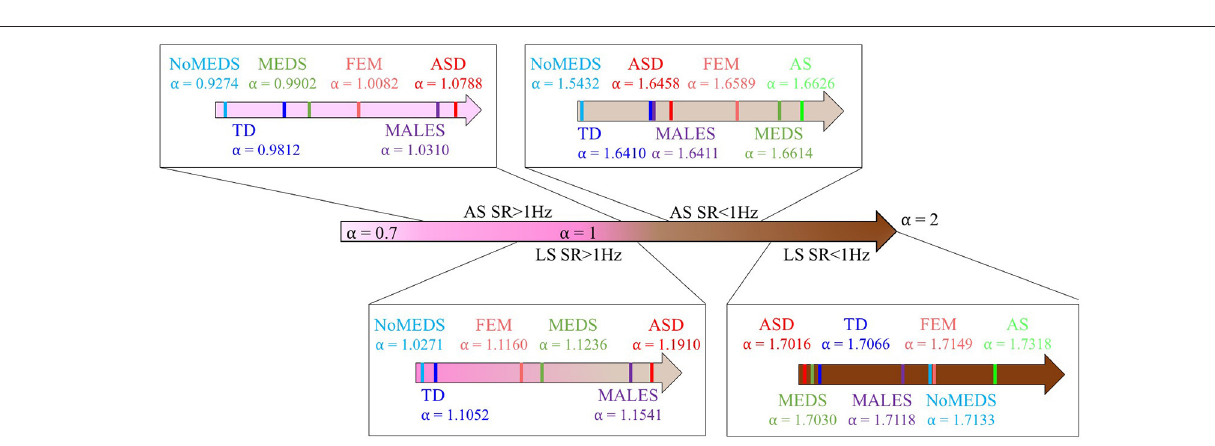
explored. Here we focused primarily on ASD (DSM-IV and